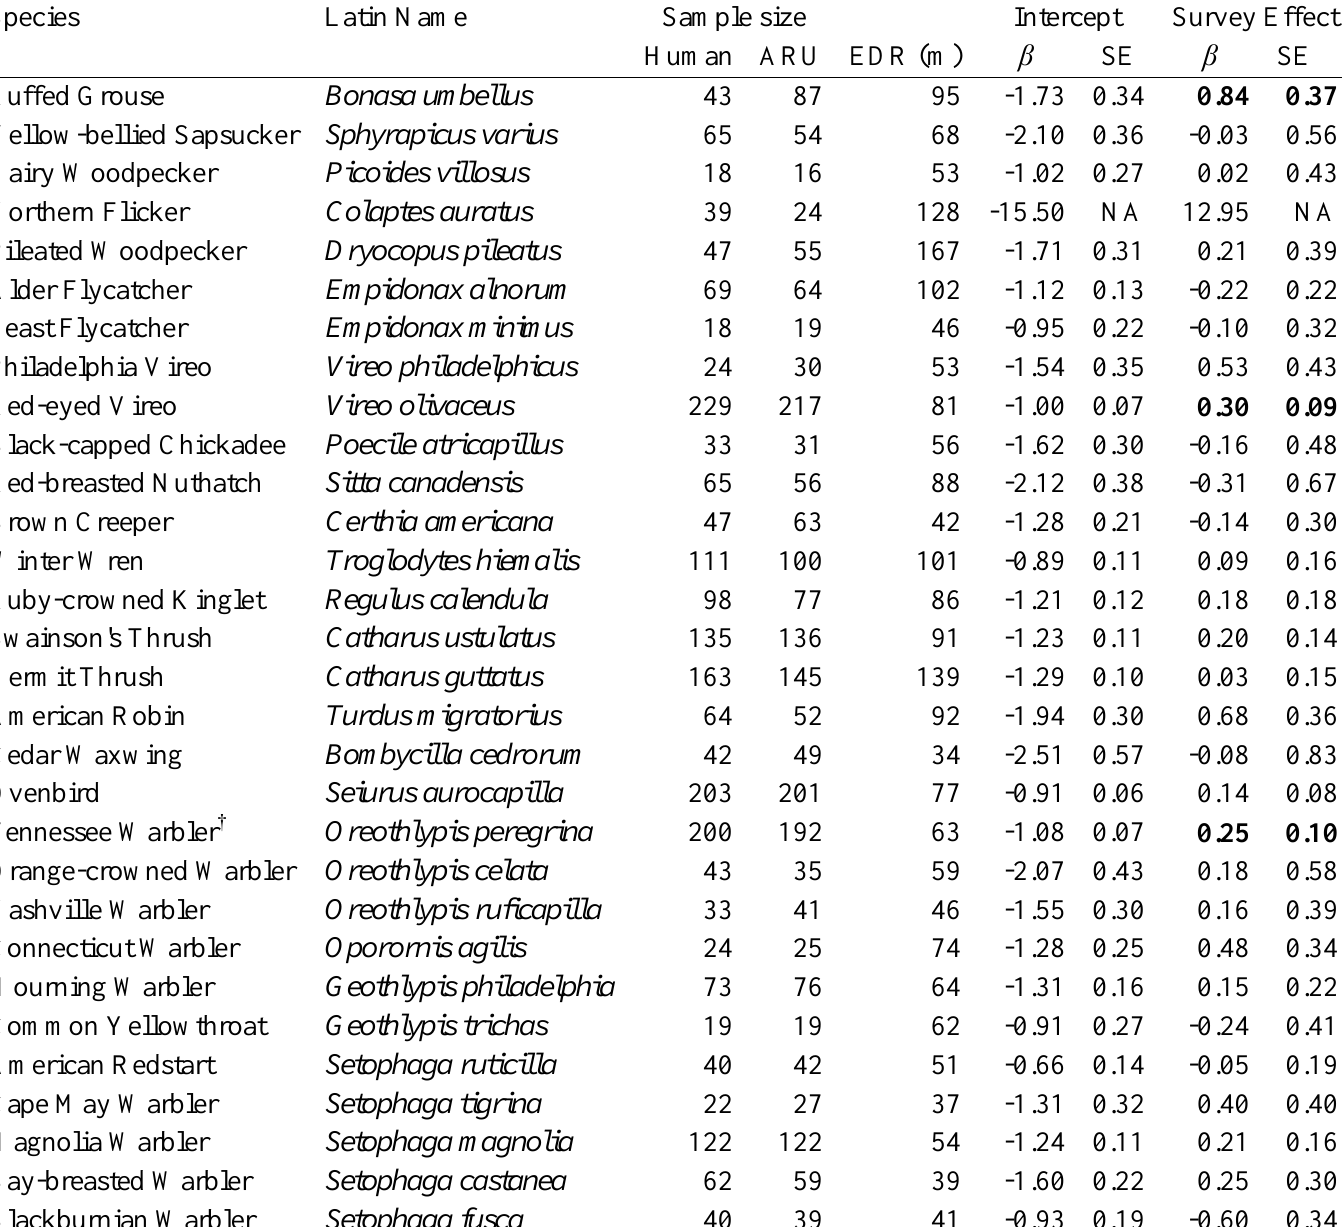
Table A1.1 Estimated effective detection radius (EDR) and parameter estimates from count removal models including both the human observer and autonomous recording unit (ARU) data with survey type included as a fixed effect factor (ARU (1) versus human as the reference category (0)) to test for a difference in species availability for 41 species (see Methods). Bold denotes parameter estimates for which 95% confidence intervals suggest the probability of an individual singing (and being detected) at least once during the cumulative duration of the count differed between human observer ( p ) and transcription from ARU ( p H A